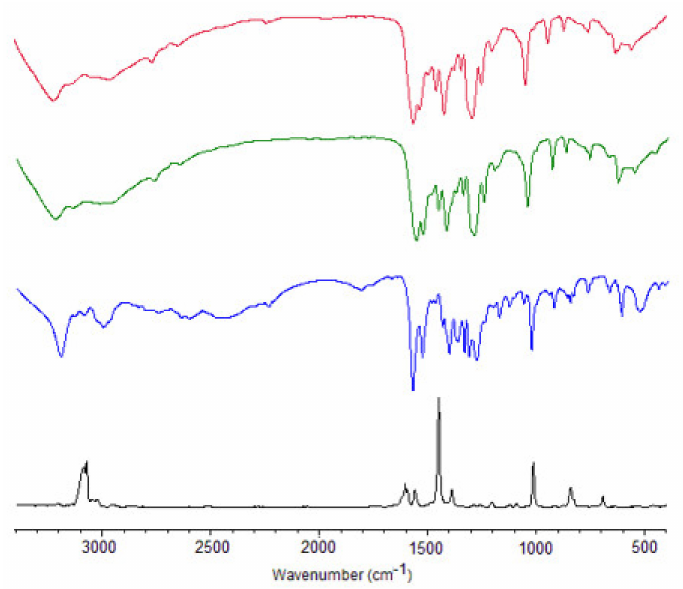
Figure 2. IR spectra of dacarbazine (blue line), cobalt complex (red line), copper complex (green line), and Raman spectra of dacarbazine (black